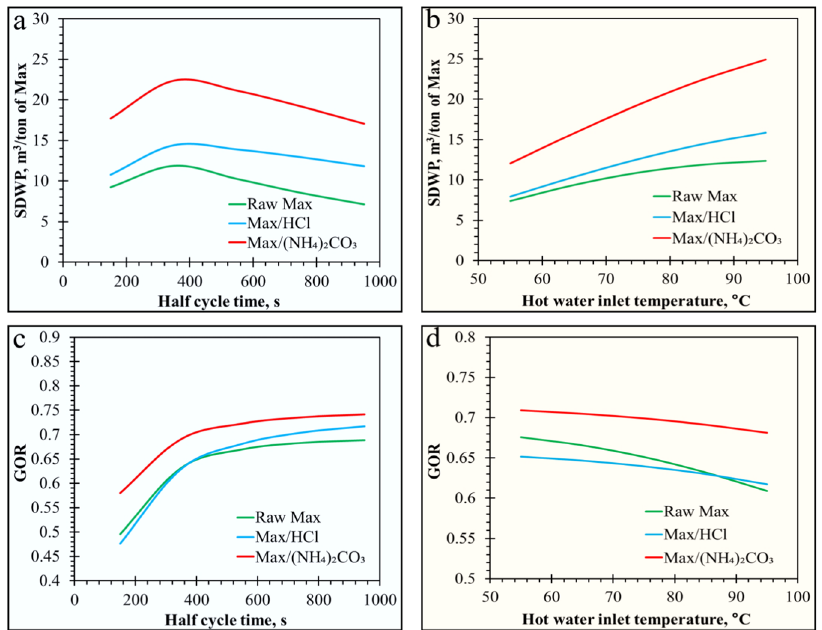
Fig. 6 AD-HR cycle performance. a SDWP with different half t cycle , b SDWP with different De-T, c GOR with different half t cycle , d GOR with different De-T. The optimum SDWP of raw and modi fi ed Max was recorded at 350 s half t cycle . The SDWP rise as the De-T increases with a slight decrease in GOR.